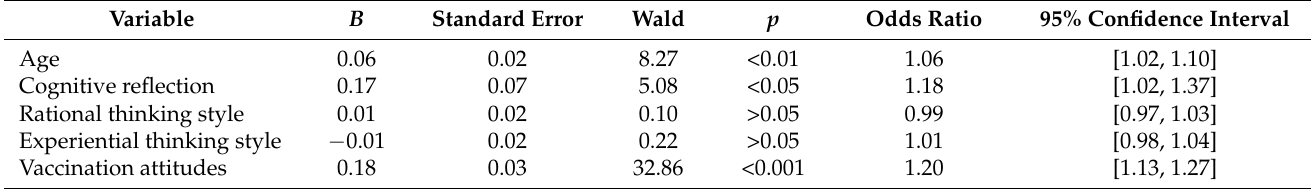
Table 2. Binomial logistic regression predicting the likelihood of receiving the COVID-19 vaccine based on age, cognitive reflection ability, rationality, experientiality, and attitudes towards